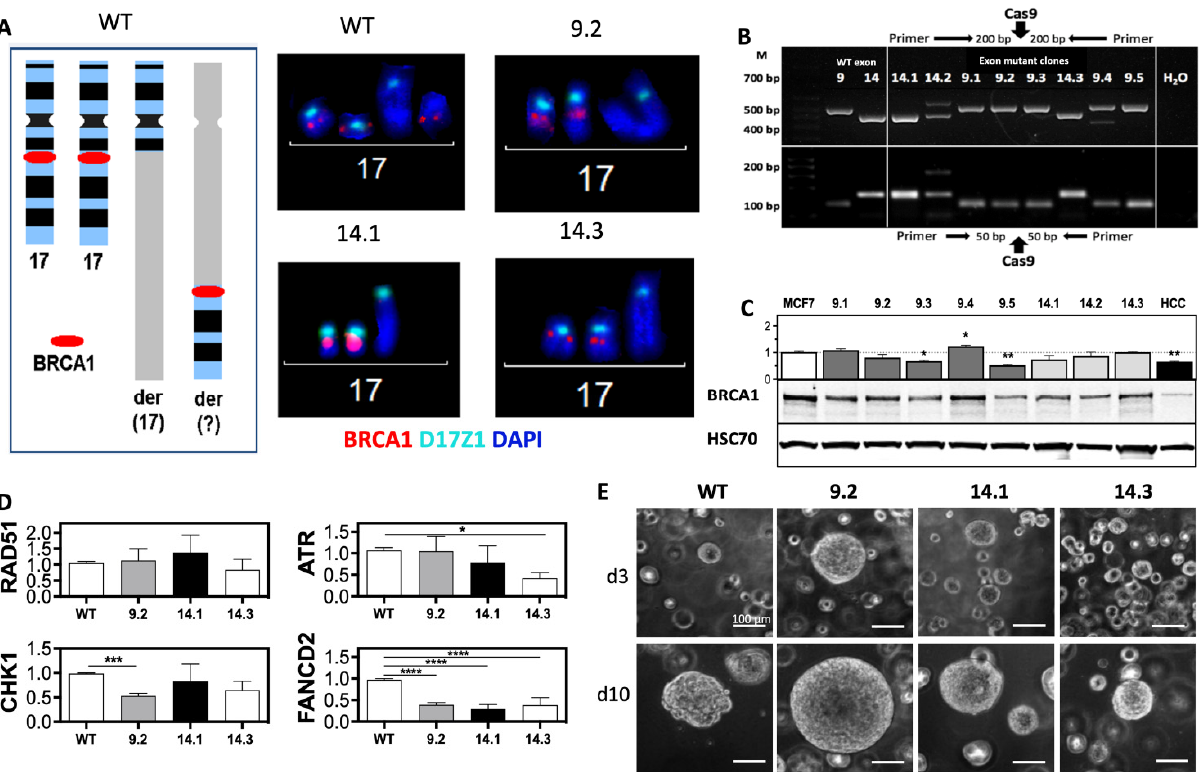
Figure 1. BRCA1 mutations in exons 9 and 14 alter protein expression and 3D growth. ( A ) FISH analysis of BRCA1 mutated MCF7 clones shows loss of one of the three BRCA1-alleles. ( B ) PCR screen of CRISPR/Cas9-targeted locus BRCA1 in exon 9 and 14 in MCF7 clones. Fragments with an amplicon size of 494 bp/101 bp (exon 9) and 419 bp/169 bp (exon 14) were selected for detection of large/small indels. PCR products were separated by electrophoresis. ( C , D ) BRCA1, RAD51, FANCD2, CHK1, and ATR expression from total cell extracts of exponentially growing cells were separated and analyzed by Western blot and normalized to MCF7 WT. HCC1937 (HCC) served as negative control and HSP70 and ß-ACTIN as loading controls. ( E ) 3D growth of BRCA1 clones mutated in exon 9 or 14. Single cells were embedded in BME, and spheroids were photographed three (d3) and ten (d10) days after seeding. Scale bars represent 100 μ m (20× magnification). Shown are the mean values of three independent experiments ± SEM. Asterisks (*) indicate significant differences (* p < 0.05; ** p < 0.01; *** p < 0.001; **** p < 0.0001 Student’s t ‐ test).